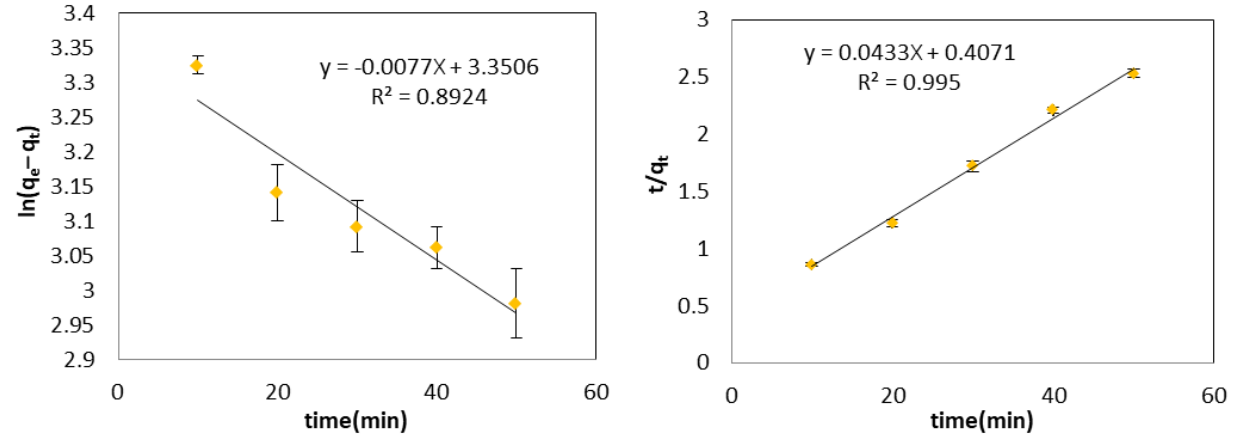
Figure 4. Pseudo-first (left) and second (right)-order models at pH = 4.0, temperature of 298 K, and A 2% by weight dosage. Error bars represent the standard deviation of triplicate measurements.